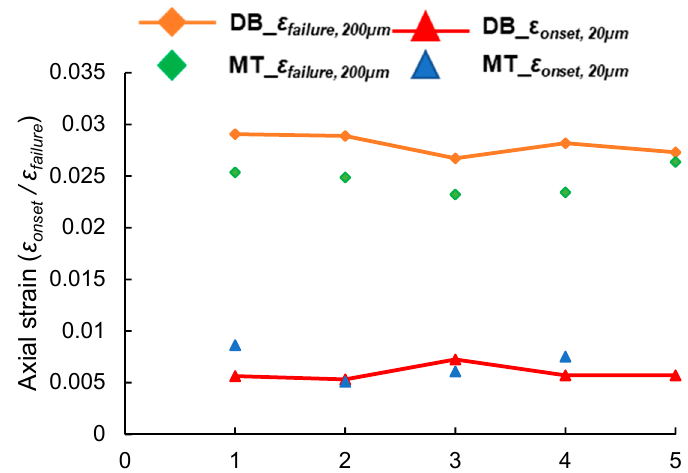
Figure 16. Comparison between axial strains calculated using the mark-tracking and displacement-based method.